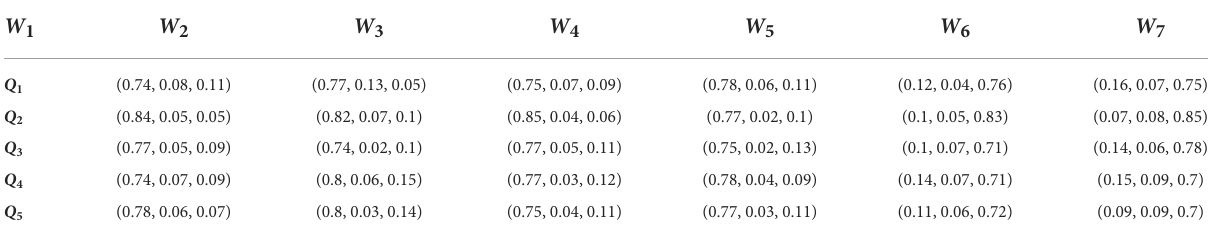
TABLE 4 Decision matrix given by the fourth